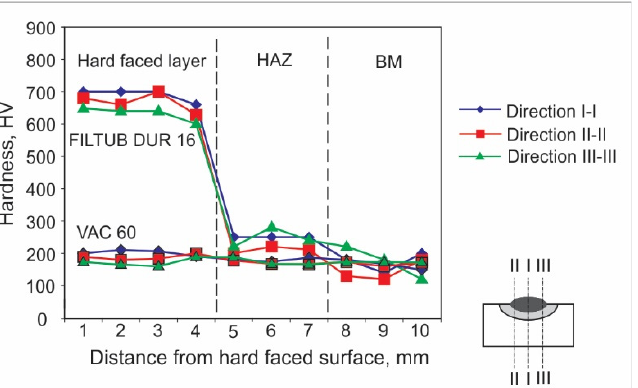
Figure 5. Hardness distribution in the hard-faced layer cross-section, BM-S235JR, FM-FILTUB DUR 16, VAC 60.